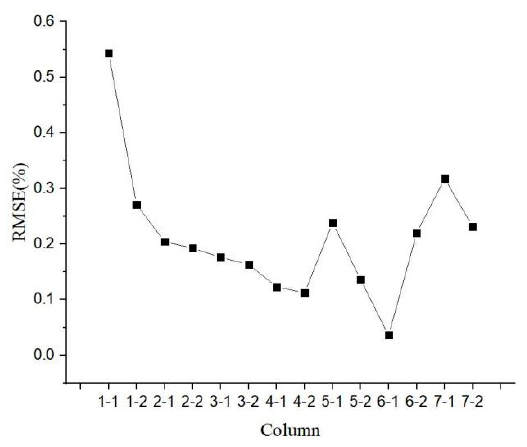
Figure 10. RMSE. Figure 10.